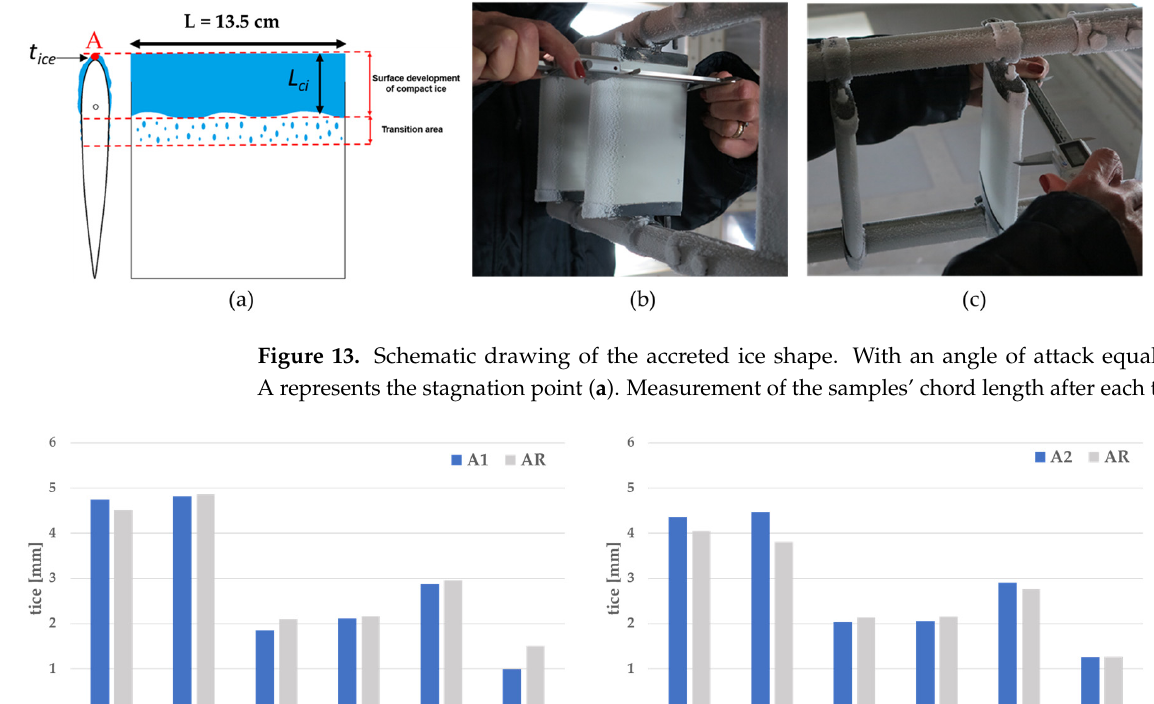
Figure 14. Accreted ice thickness t ice on A1 and AR ( a ), and on A2, and AR ( b ), during the IWT tests.